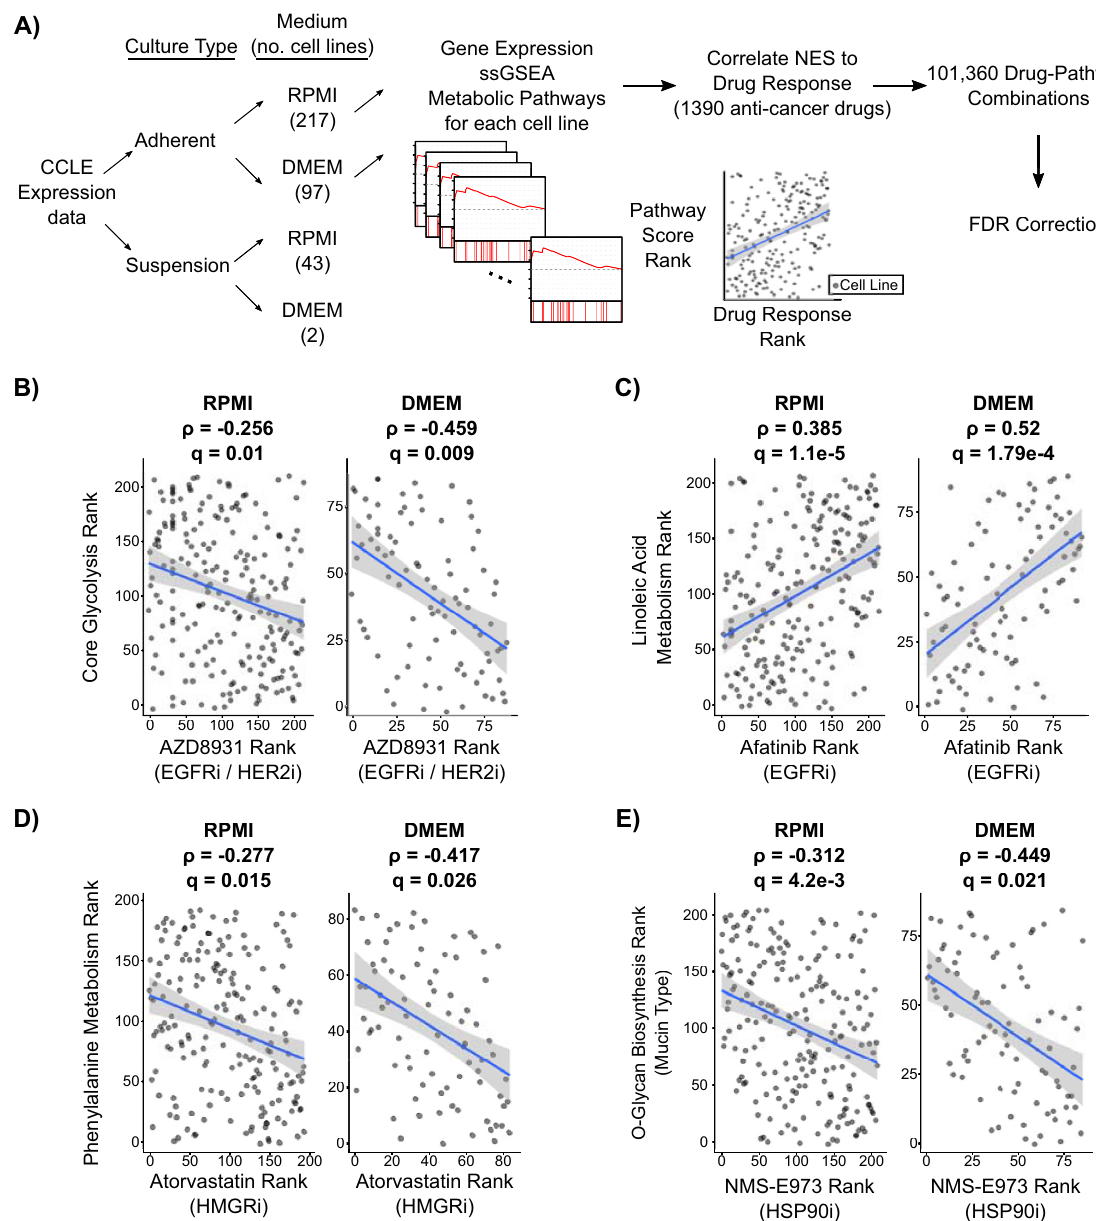
Fig 4. Metabolic pathway activity identifies anti-cancer drug sensitivity independent of cell culture medium. A) Schematic representing the strategy used to integrate metabolic pathway activity with drug response screens. Cancer cell lines were separately processed by culture type and culture medium with a focus on adherent cell lines. All correlation p-values were FDR corrected using a Benjamini-Hochberg correction. B-E) Scatter plots of significant drug:metabolic pathway combinations (FDR < 0.05) in both DMEM and RPMI mediums. Correlation coefficients and FDR corrected p-values are shown for each correlation. The annotated gene target of each drug is listed below the drug name. The remaining significant associations are listed in S2 Table.